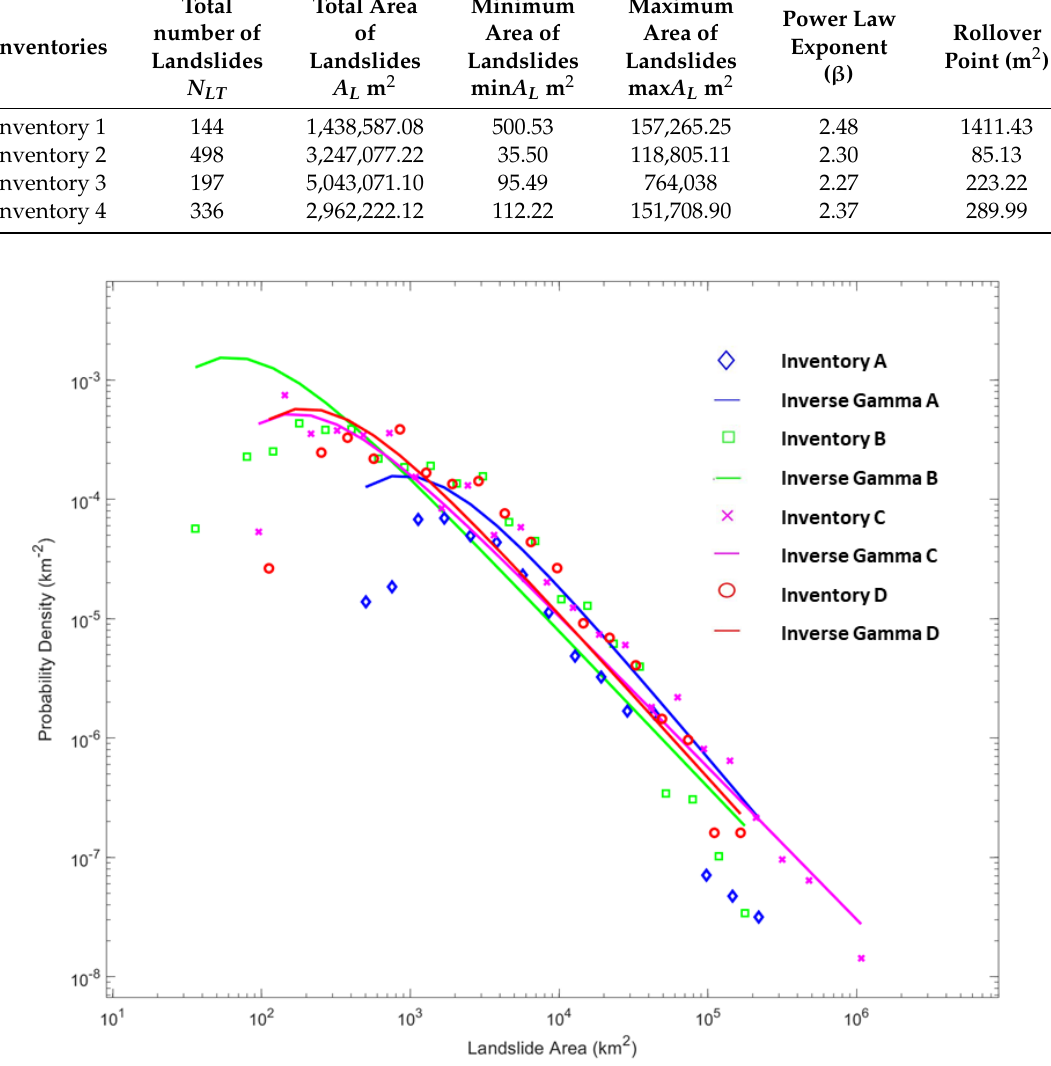
Figure 9. Landslide frequency size distribution, representing the dependence of landslide probability density p on the landslide area.